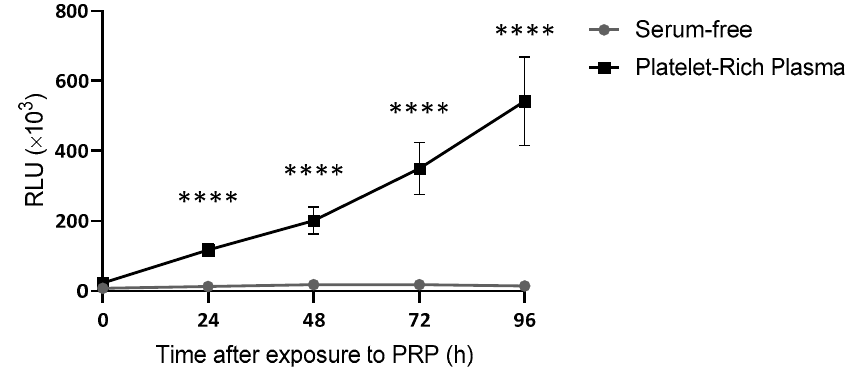
Figure 3. Growth curves of dermal fibroblasts cultured with PRP or serum-free. Cell viability was measured every 24 h for a total of 96 h. The statistical significance of the differences in proliferative capacity between the two conditions was determined by t -test at each time-point (**** p < 0.0001) ( n = 30).